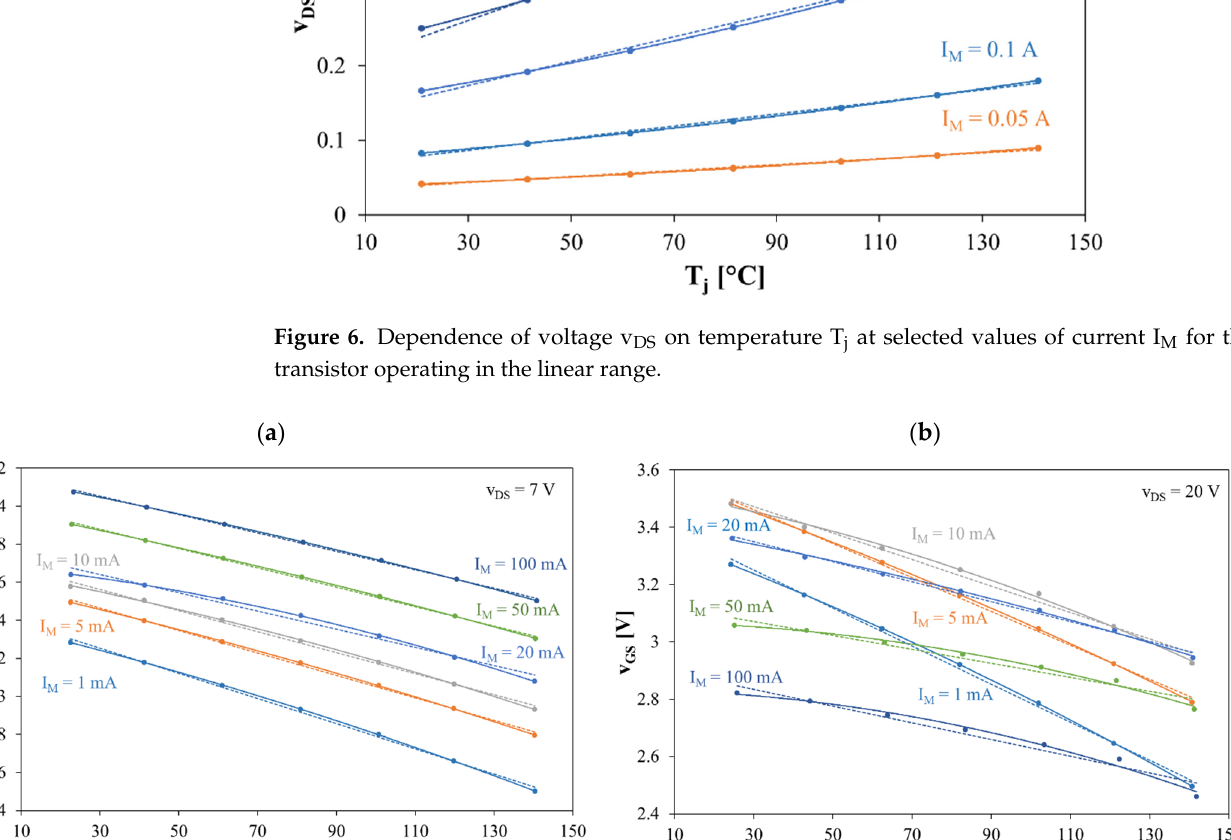
Figure 7. Dependences of voltage v GS on the temperature at selected values of current I M for voltage v DS equal to: ( a ) 7 V